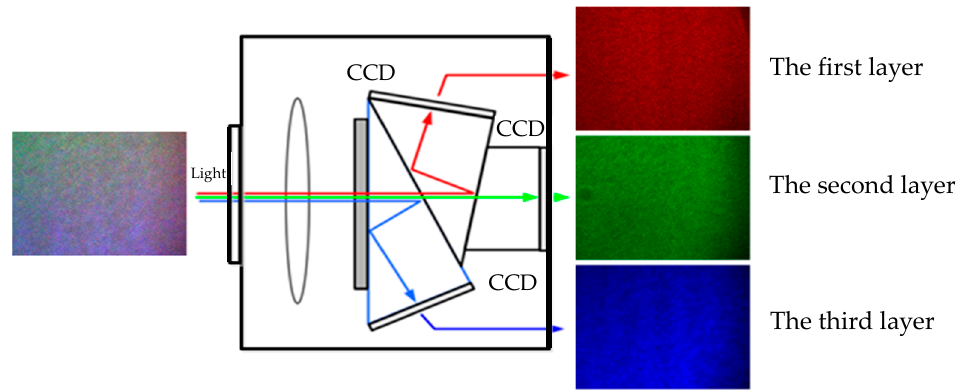
channels respectively.